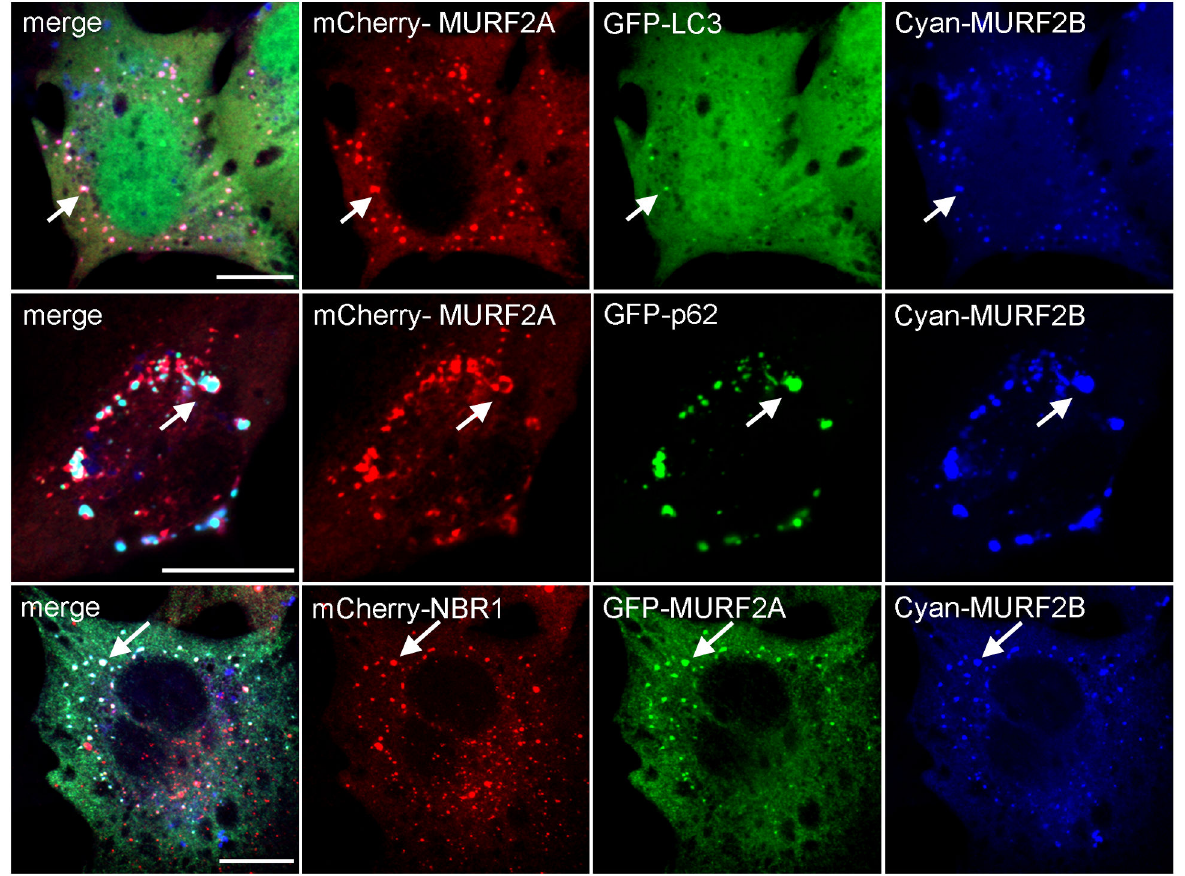
Figure 3. MURF2A and MURF2B colocalize with autophagic proteins. Triple co-transfections were performed in C2C12 myoblasts with combinations of various plasmids encoding the mentioned tagged proteins. Direct observation of fluorescent proteins was performed by confocal microscopy. Arrows show colocalization of the proteins on vesicles and aggregates. Scale Bar: 10 µm. doi: